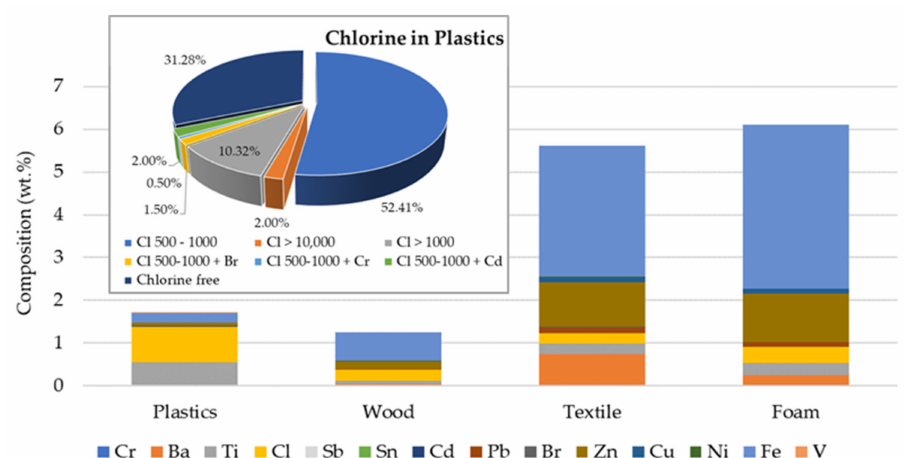
Figure 1. Results of elemental analysis of the main material fractions in the SRF, with breakdown of its chlorine content in plastics.